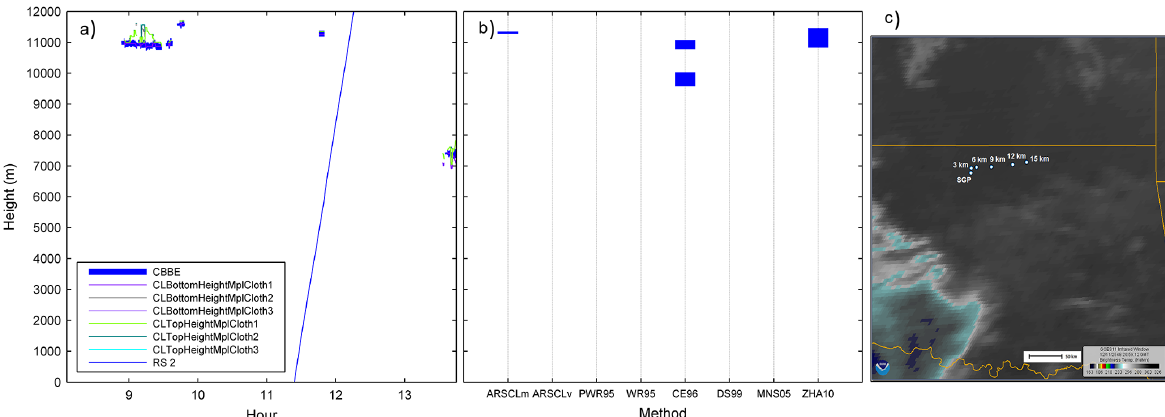
Figure 3. Case 1: 15 April 2009, no clouds. (a) Vertical position of the radiosounding depending on the time and the ARSCL products around the RS launch time (11:21UTC). (b) Cloud layers as detected by ARSCL (ARSCLm and ARSCLv), and as found by the explained methods (PWR95, WR95, CE96, DS99, MNS05 and ZHA10). (c) GOES image in the infrared channel at 12:00UTC (approximately 30–45min from the launch time). Dots indicate the horizontal position of the RS every 3km in